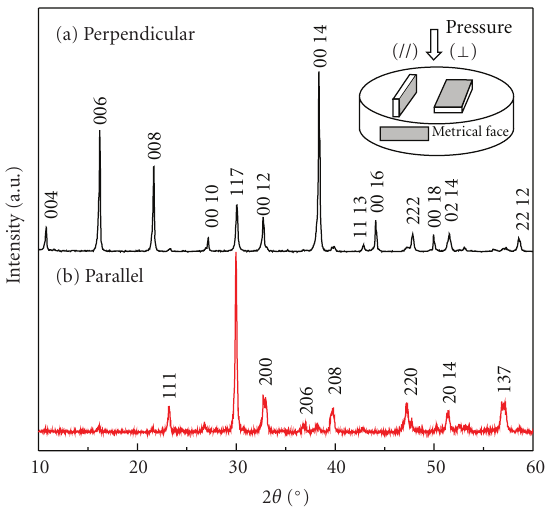
Figure 1: XRD patterns of the grain-oriented BIT ceramics (a) perpendicular, (b) parallel to the press direction and inter: sketch of samples preparation. Samples were cut from the cylindrical samples along the directions parallel and perpendicular to the pressing